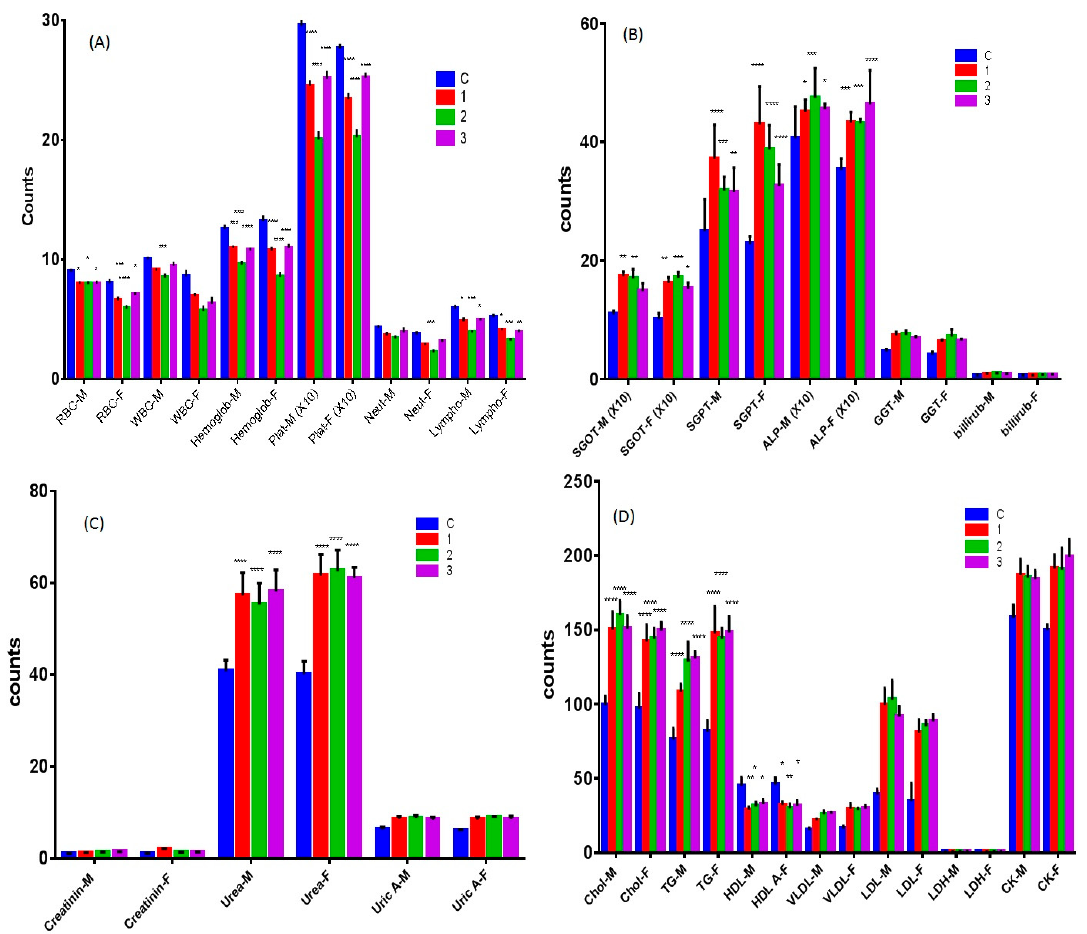
Figure 9. Chronic toxicity profile of complexes 1 , 2 and 3 . Effect of complexes 1 , 2 and 3 on ( A ) blood components, ( B ) biochemical parameters of liver function, ( C ) biochemical parameters of kidney function, and ( D ) biochemical parameters of lipids and heart function. M and F denote male and female mice, respectively. Statistical analysis was performed by two-way ANOVA, Dunett as post-Hoc test compared to control ( C ), n = 4. (* p < 0.05; ** p < 0.01; *** p < 0.005; **** p <